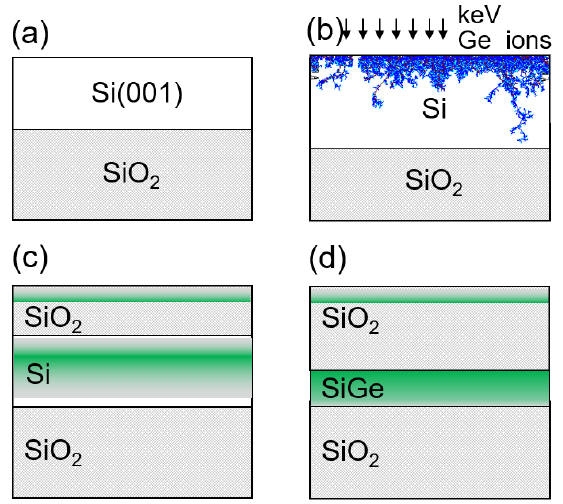
Figure 8. Schematic description of the two-step oxidation process: ( a ) starting substrate consists of 220 nm thick Si on 2000 nm Berried-Oxide Silicon-on-Insulator (BOX SOI); ( b ) implantation of 5 × 10 16 Ge cm − 2 at 33 keV; ( c ) primary oxidation at 870 °C used to cap the Silicon-Germanium-on-Insulator (SiGeOI, resulting in a mixed oxide; and ( d ) secondary oxidation at either 900° or 1000 °C to form final SiGeOI structure. Adapted from [15] .